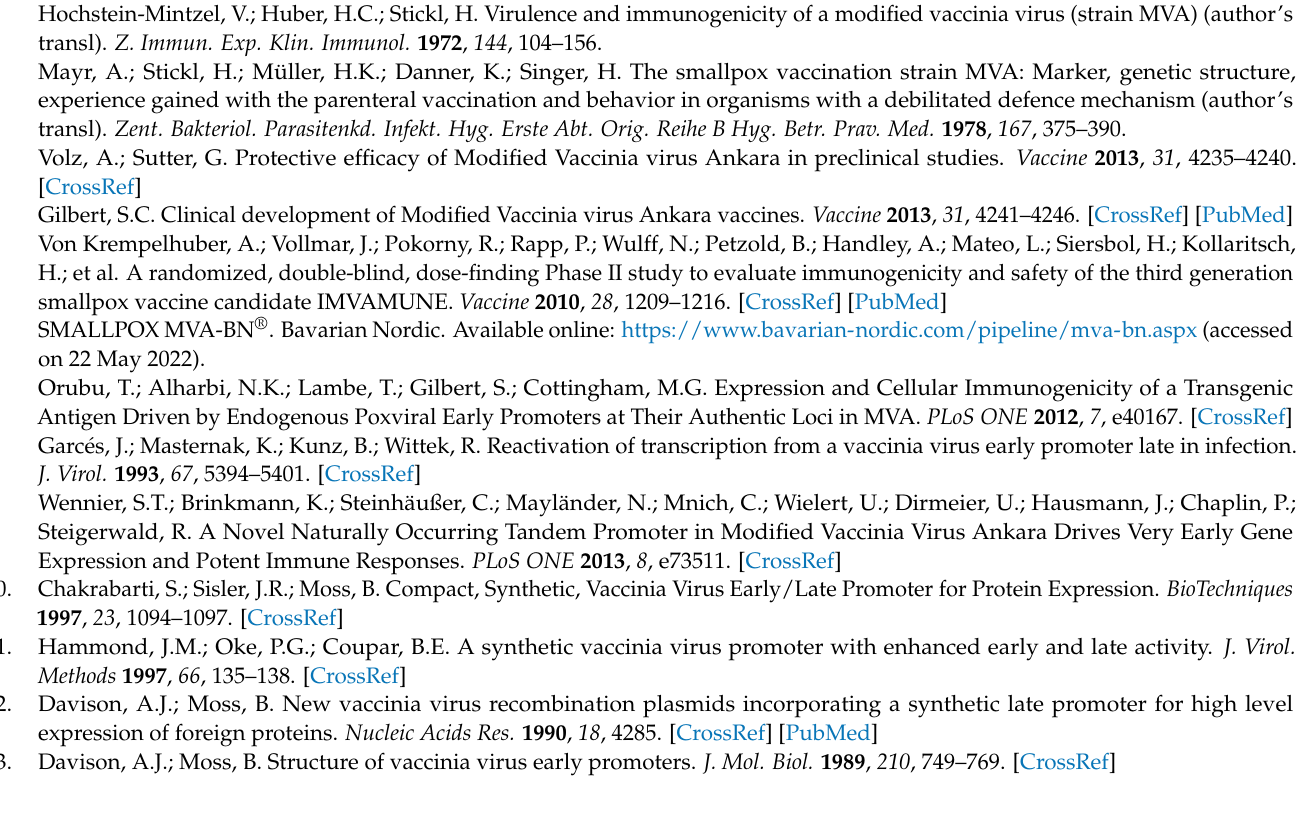
10.3390/vaccines10081330/s1, Clearer versions of figures are available in supplementary mate- rials for: Figure S1. Diagram representation of mouse (A) and camel (B) vaccination studies. Figure S2. Humoral and cellular immunogenicity of MVA-wt and MVA-MERS prime–boost vaccina- tion in BALB/c mice. Figure S3. Humoral immunogenicity of homologous MVA-MERS prime–boost vaccination in dromedary camels. Figure S4. Antibody specific to MVA in immunised mice and camels. They are the same but with higher